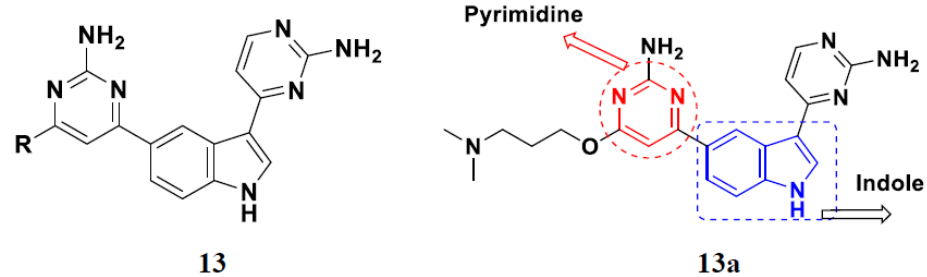
Table 13. In vitro cytotoxic activities of indole ‐ pyrimidine based hybrid compounds 13 ( b – e ). Figure 15. Structure of indole-pyrimidine based hybrids and the most promising compound 13a . Compound R No.